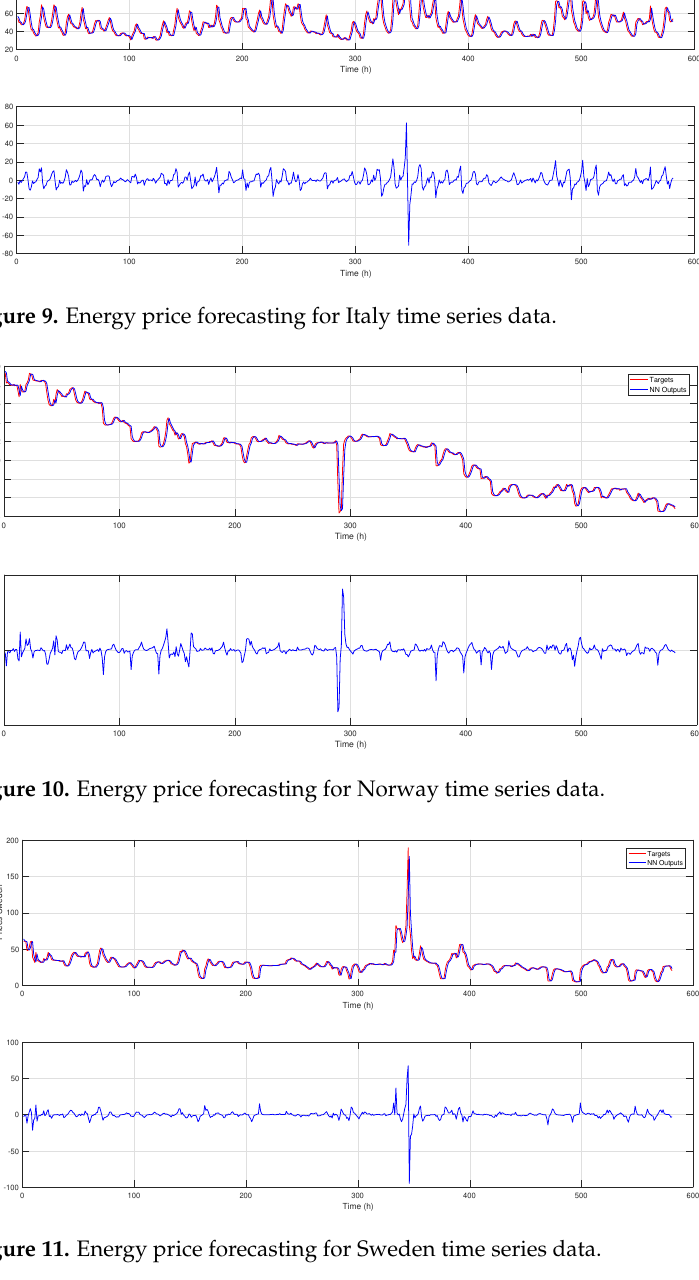
Figure 11. Energy price forecasting for Sweden time series